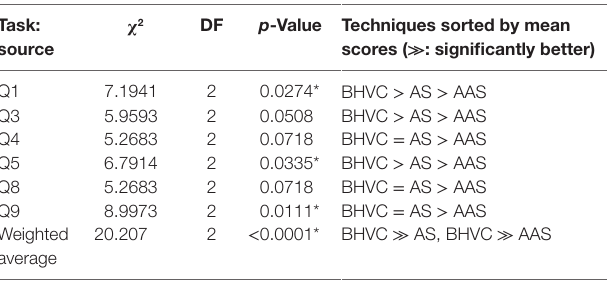
TaBle 2 | effects of interaction technique on grades for only significant or close-to-significant p Values ( < 0.1). Task: χ 2 DF p -Value Techniques sorted by mean source scores ( ≫ : significantly